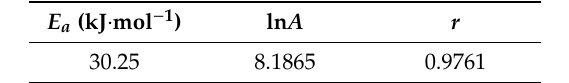
Figure 10. The catalytic degradation mechanism of methyl orange by self-assembled nano-Fe 3 C@RGO aerogel.